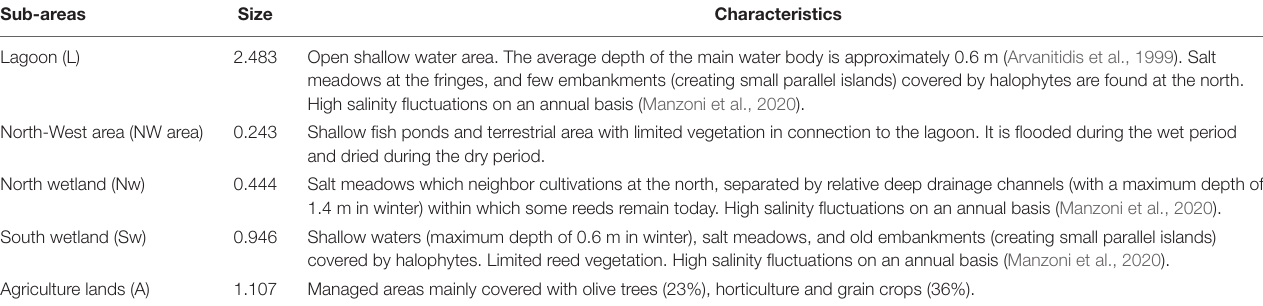
TABLE 2 | Description of the sub-areas inside the GLw-Natura2000 area, based on Maneas et al. (2019). Sub-areas